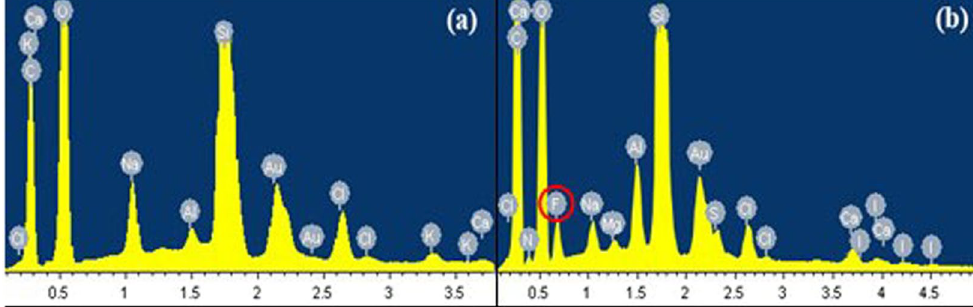
Figure 3. EDS of the shale surface: ( a ) untreated rock, ( b ) treated.